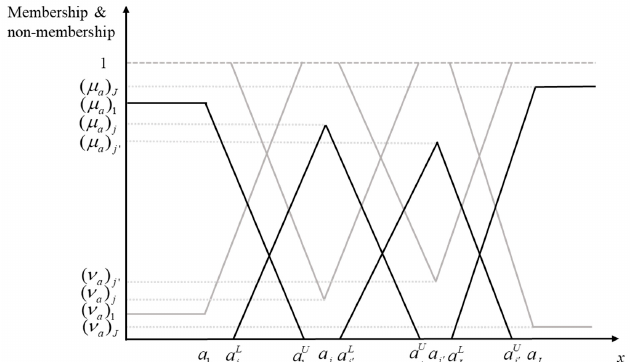
Figure 5. Membership and non-membership function when 4 J = .